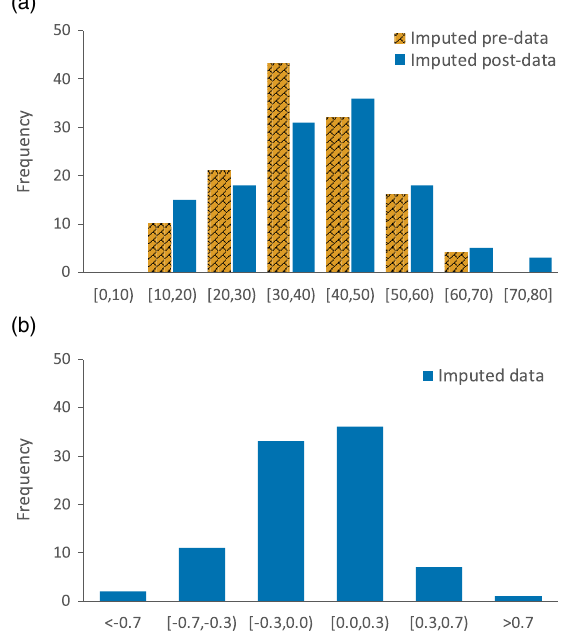
FIG. 4. (a) The distribution of the imputed pre (orange hatched pattern) and post (dark blue solid) anxiety scores showing slight right skewing. (b) The normalized shift at individual level as defined in Eq. (1).